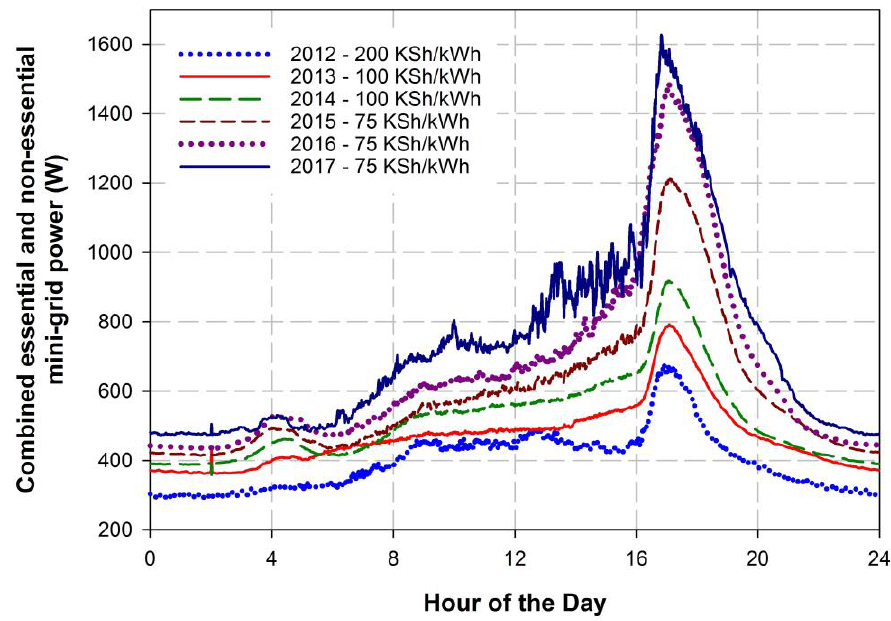
Figure 9. Average daily load profile in Kitonyoni corresponding to the periods (a), (b), (c) and (d) and years of operation as shown in Figure 9.